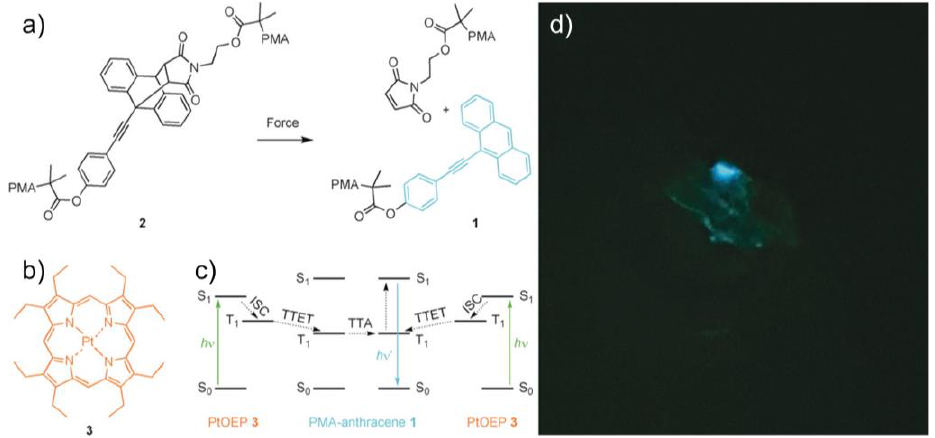
Figure 9. ( a ) Retro Diels – Alder reaction of PMA-substituted anthracene – maleimide to yield the PMA-substituted induced by mechanical force. ( b ) Triplet sensitizer octaethylporphyrin (PtOEP) used in Ref. [89]. ( c ) Jablonski diagram of the TTA-UC process in which 1 served as annihilator and emitter and 3 as the triplet photosensitizer. ( d ) The blue UC emission of the PHMA in solid state when swelled in a PtOEP solution. Reproduced with permission from Ref. [89]. Copyright 2019, Wiley-VCH.